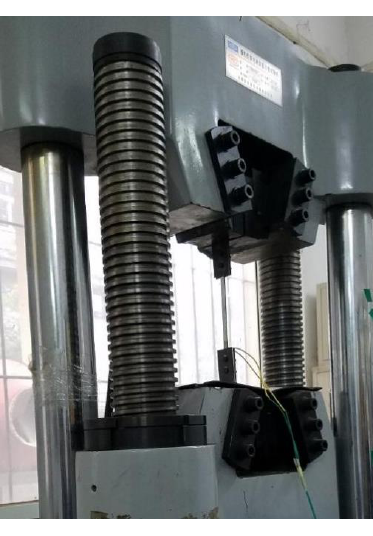
Figure 8. Setting up of the coupon test. Table 2. Material properties of U-shape connectors and SHS members.